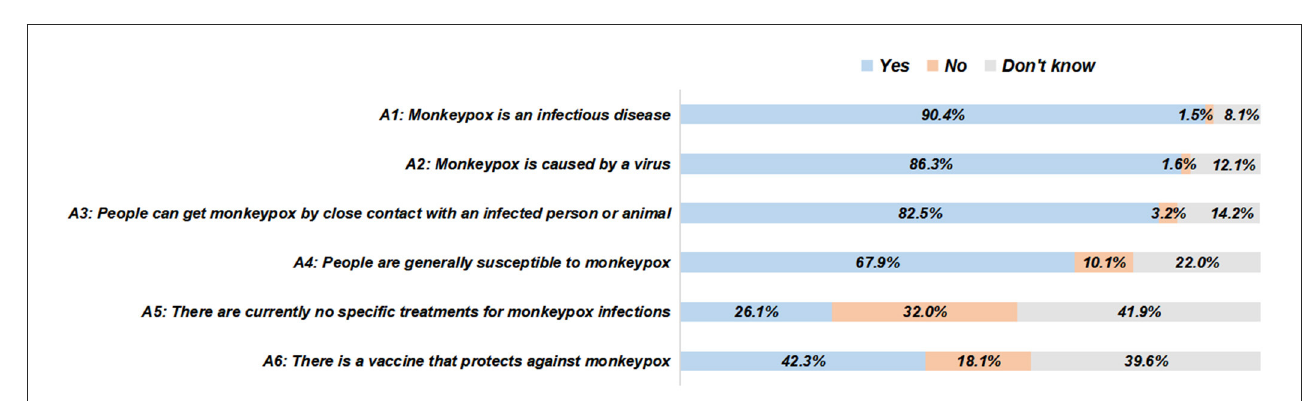
FIGURE2 The responses to specific knowledge items of mpox among people who were aware of mpox ( N = 801).